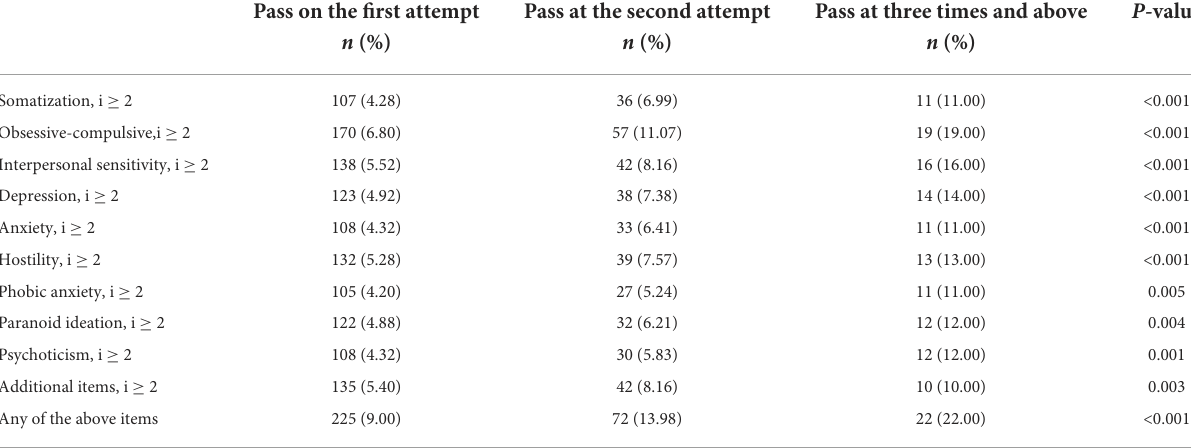
TABLE 6 Prevalence of each psychological symptom among drivers with different frequencies of passing the DLT. Pass on the first